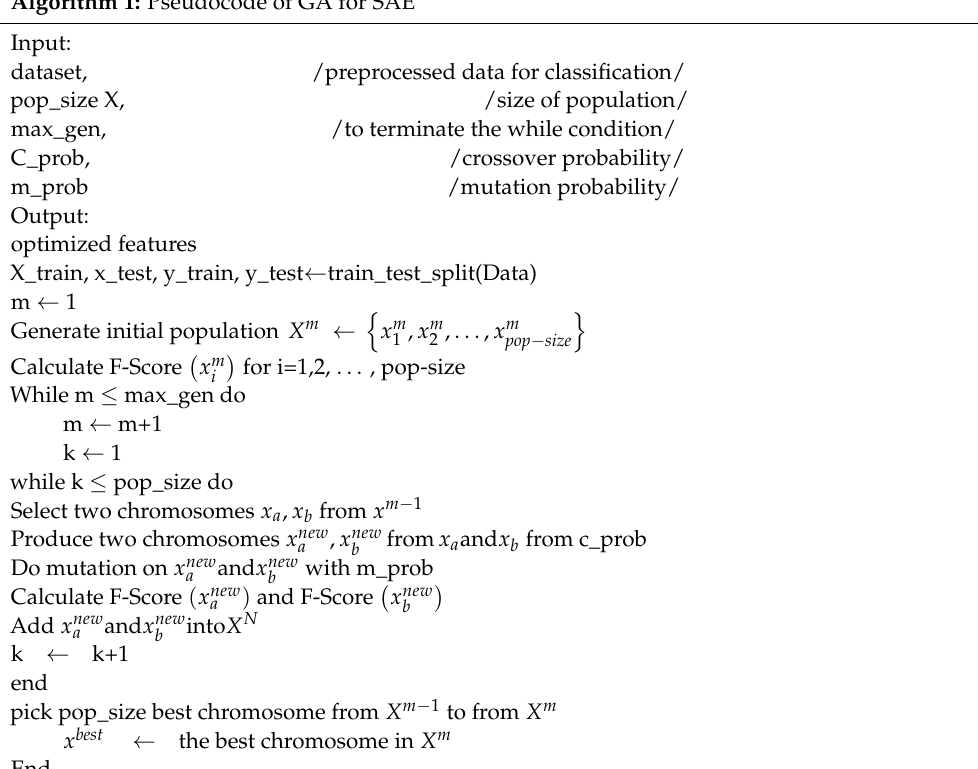
Algorithm 1: Pseudocode of GA for